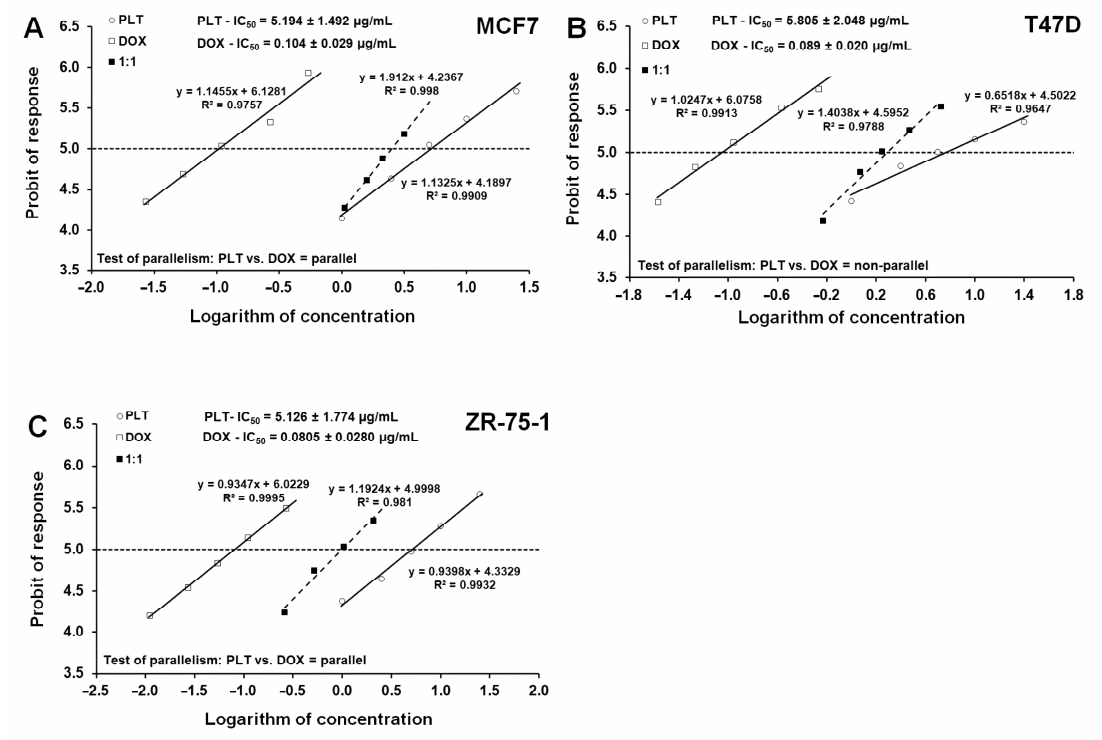
Figure 7. The effect of doxorubicin (DOX) on the viability of human breast cancer cell lines was measured by MTT assay after 72 h. Results are presented as mean ± SEM at each concentration. (** p < 0.01; **** p < 0.0001), n = 40 per concentration from five independent experiments.